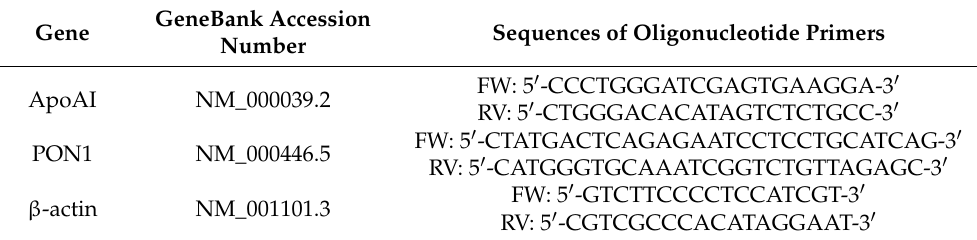
Table 1. Sequence of primers used for Real-Time PCR